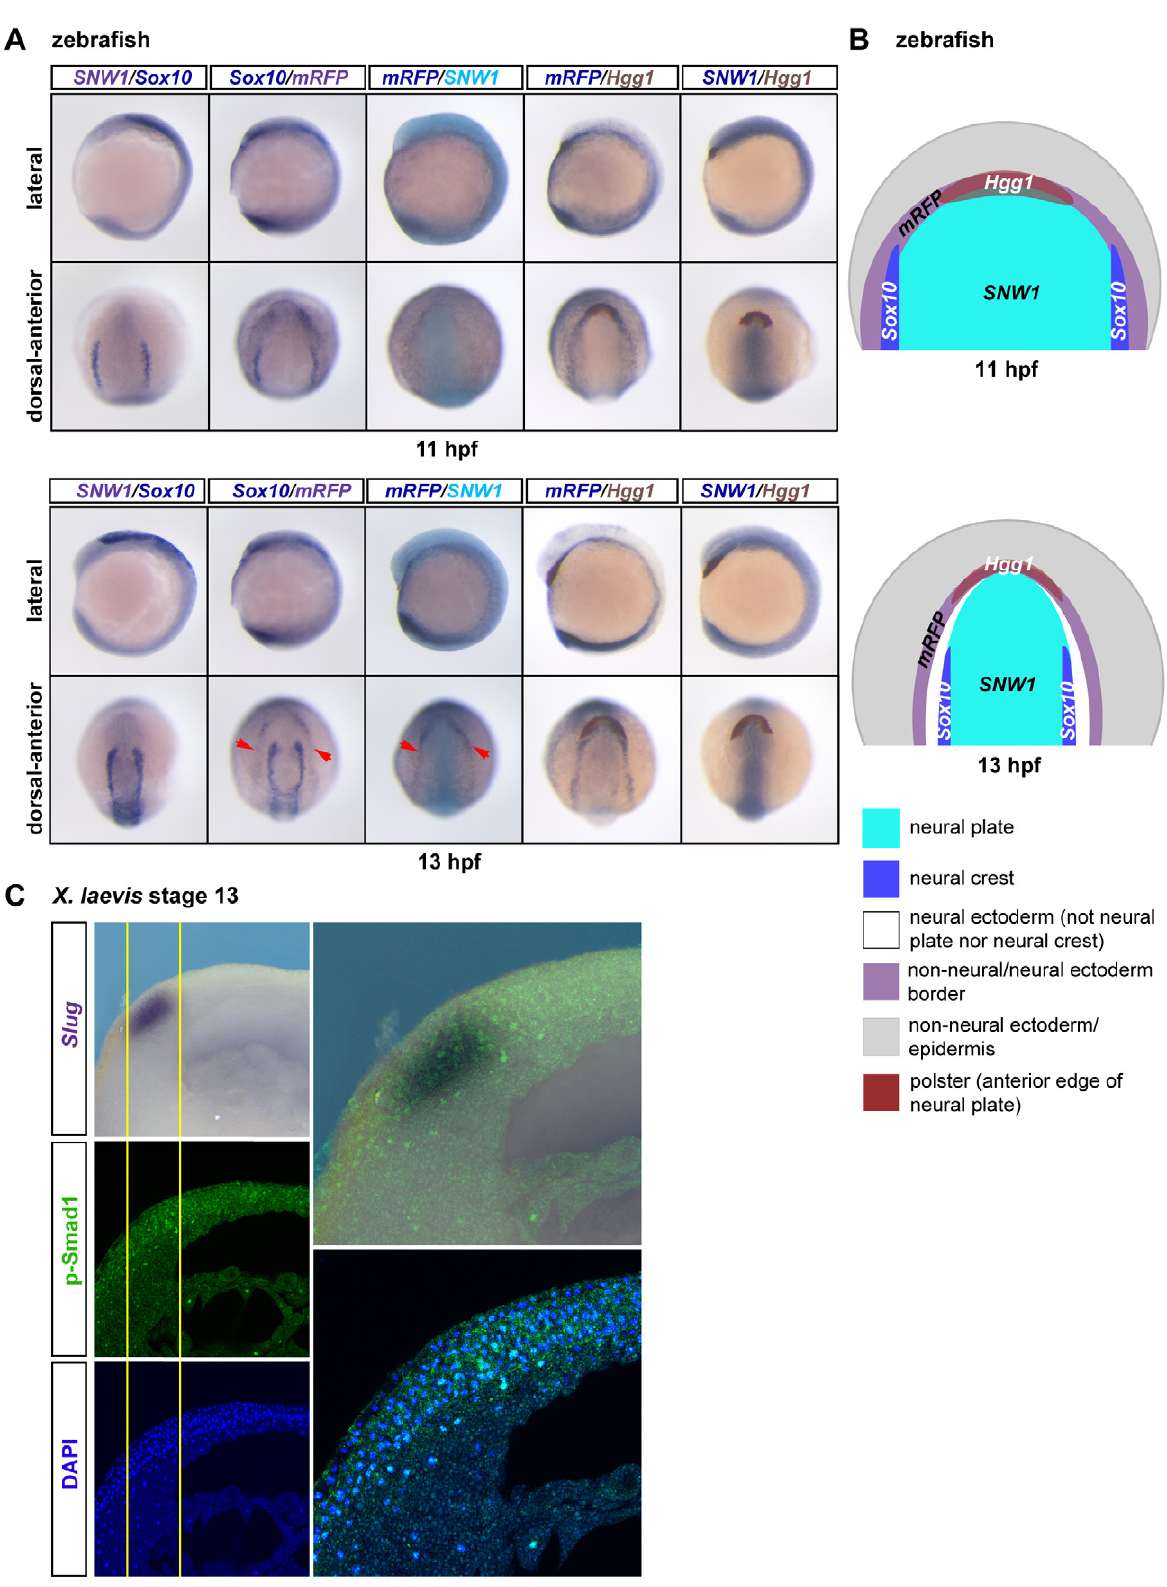
Figure 6. In post-gastrula zebrafish and Xenopus embryos the neural crest domain overlaps with the dorsal-anterior domain of BMP activity. (A) At early segmentation stages of zebrafish development the domains of expression of SNW1 and Sox10 partially overlap with the anterior ‘‘horseshoe’’ domain of BMP activity. Transgenic BRE- mRFP zebrafish embryos were stained for SNW1 (grey-purple) and Sox10 (dark blue), Sox10 (dark blue) and mRFP (grey-purple), mRFP (dark blue) and SNW1 (turquoise), mRFP (dark blue) and Hgg1 (maroon), or SNW1 (dark blue) and Hgg1 (maroon)